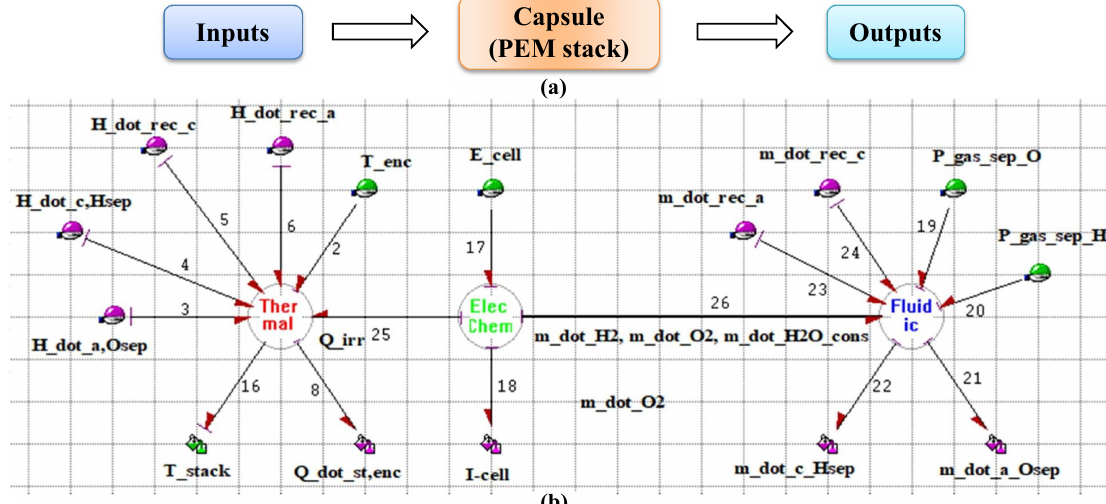
Figure 5. ( a ) Schematic diagram and ( b ) BG model of PEM electrolyser stack